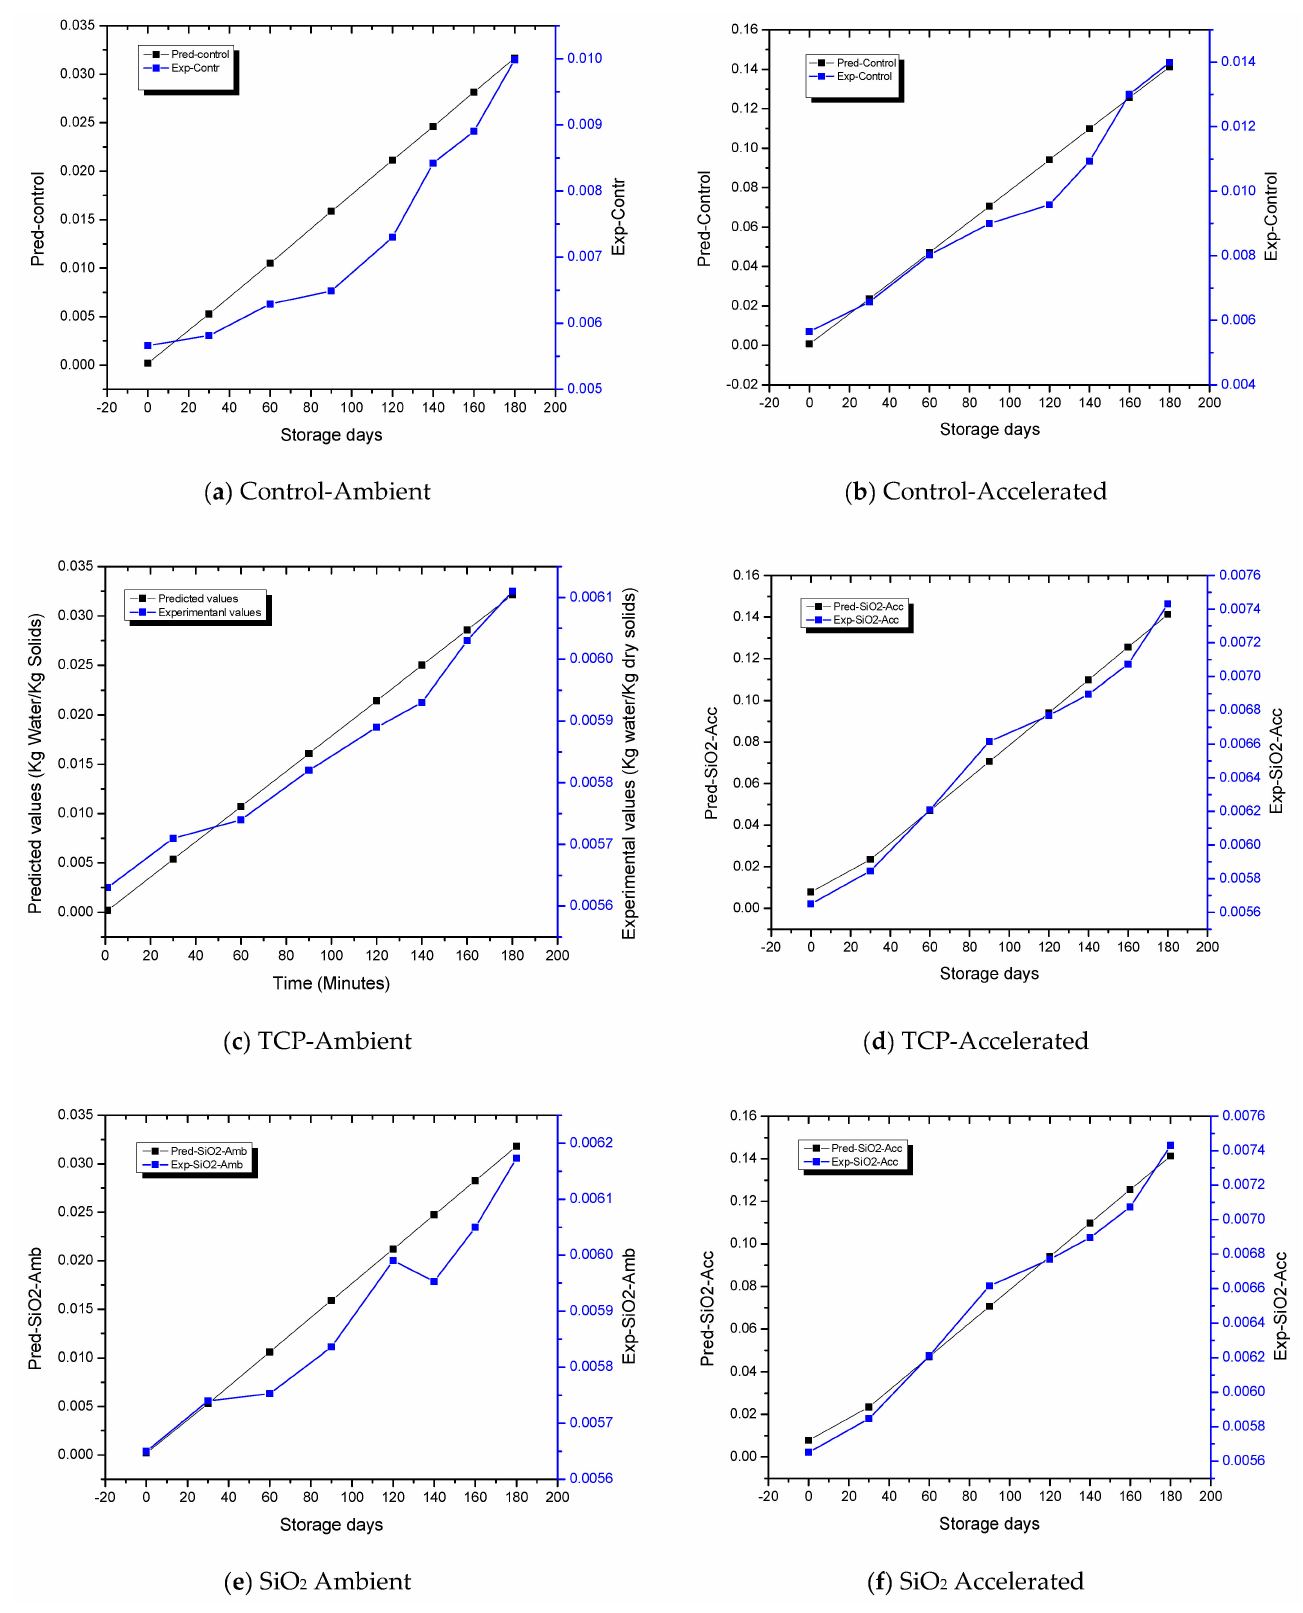
Figure 3. Graphical relationship between the time of storage and moisture content of spray-dried apricot